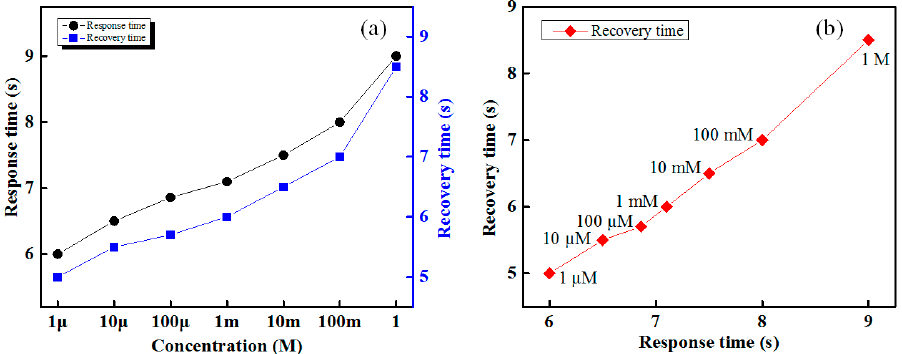
Figure 9. Response of the proposed IDC glucose biosensing system: ( a ) response and recovery times; and ( b ) response vs. recovery times at different concentrations of glucose for Nile-red-containing IDC sensing element.